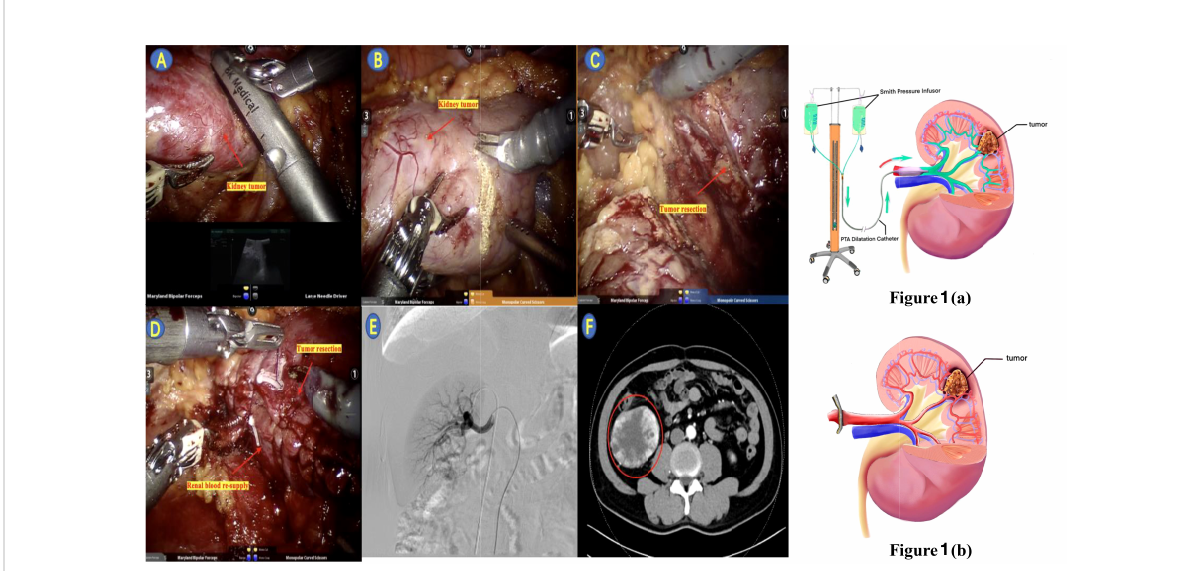
FIGURE 1 The schematic diagram of the P-RALPN shown as (a) and S-RALPN shown as (b) ; (A) Ultrasound located the tumor intra-operation; (B) Balloon perfusion began, renal artery occlusion; (C) Tumor resection; (D) Renal artery occlusion completed and renal blood re-supply; (E) Pre-operative angiography con fi rmed the presence of renal arteriovenous ducts; (F) Pre-operative enhanced CT results of